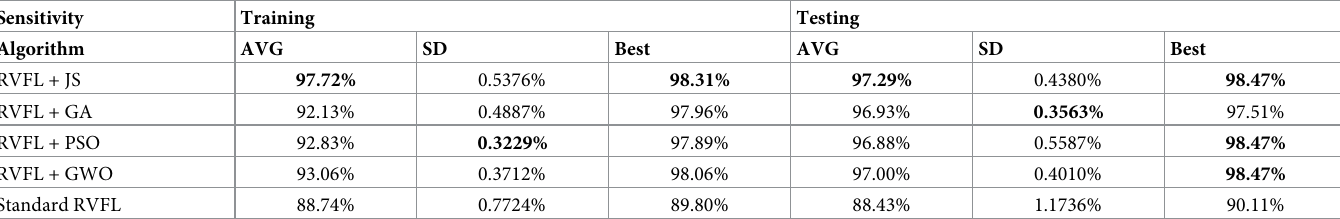
Table 8. Measurement sensitivity of RVFL+ JS against other metaheuristic algorithms. Sensitivity